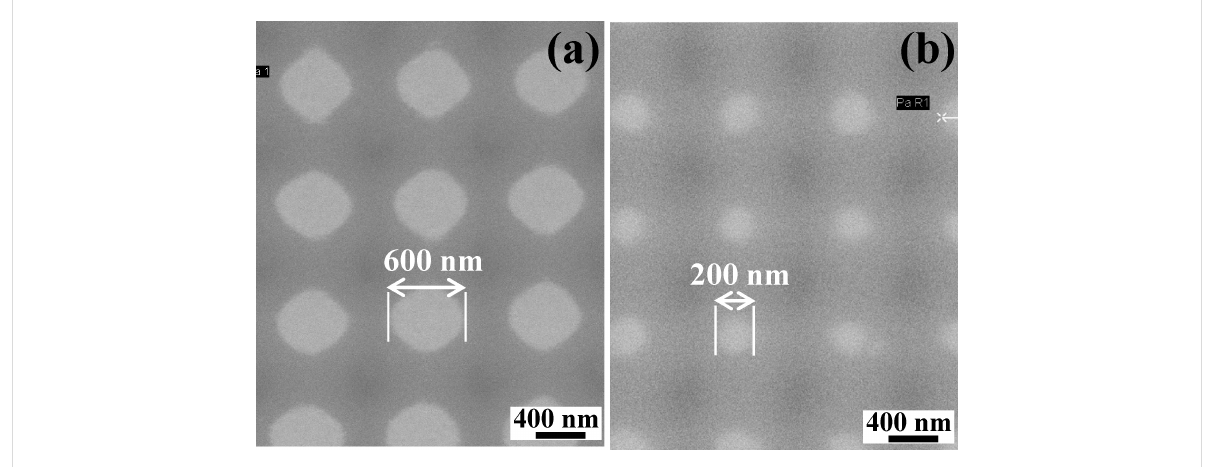
Figure 1: Field emission scanning electron microscopy images of (a) polymer-coated ITO patterned with a pore size of ≈ 600 nm, and (b) polymer- coated ITO patterned with a pore size of ≈ 200 nm.